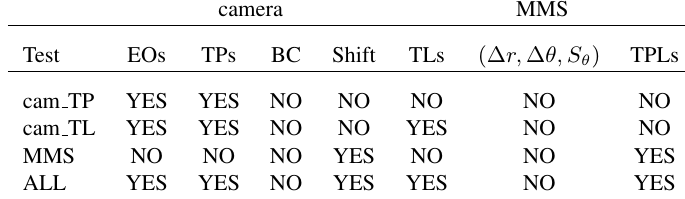
Table 5: Observations of block configurations.